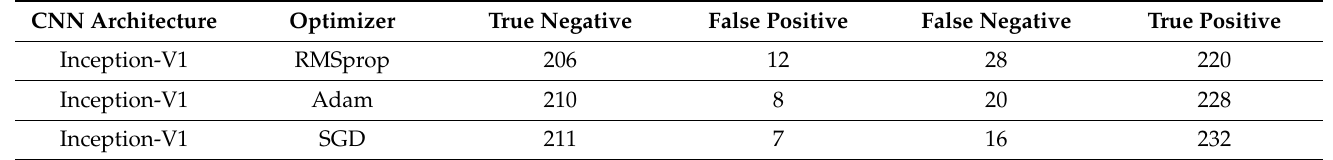
Table 10. Inception-V1 confusion matrix (validation).